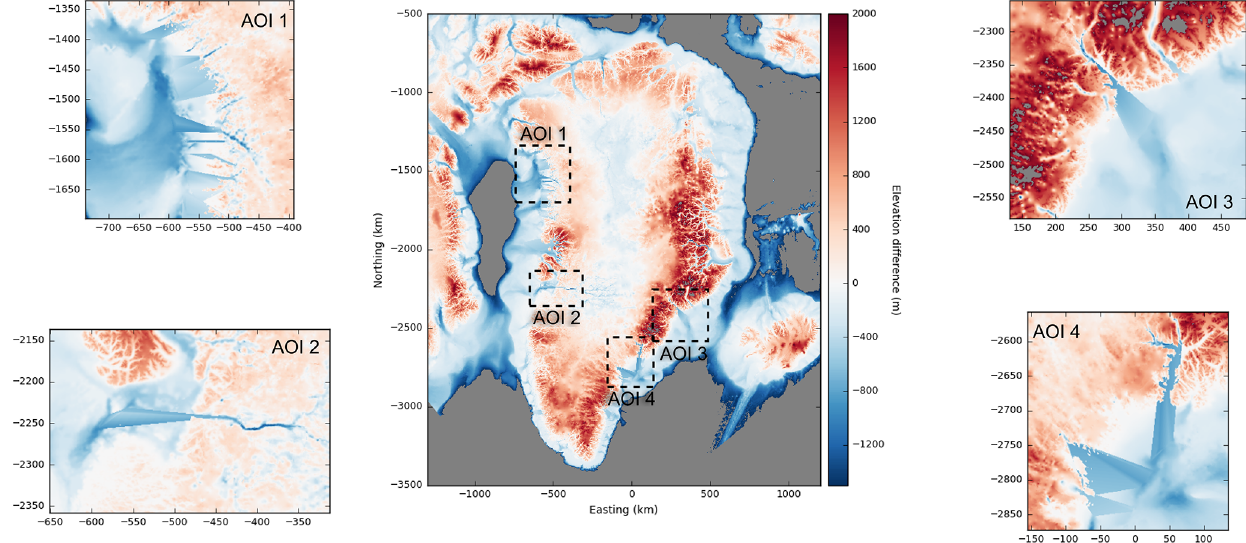
Figure 1. Examples of non-physical bathymetry around the coast of Greenland following Bamber et al. (2013), using only observations included within the IBCAO v3 (Jakobsson et al., 2012) DEM. Within the fjord mouths, discontinuities in the direction of ice flow were removed, resulting in discontinuities at the lateral